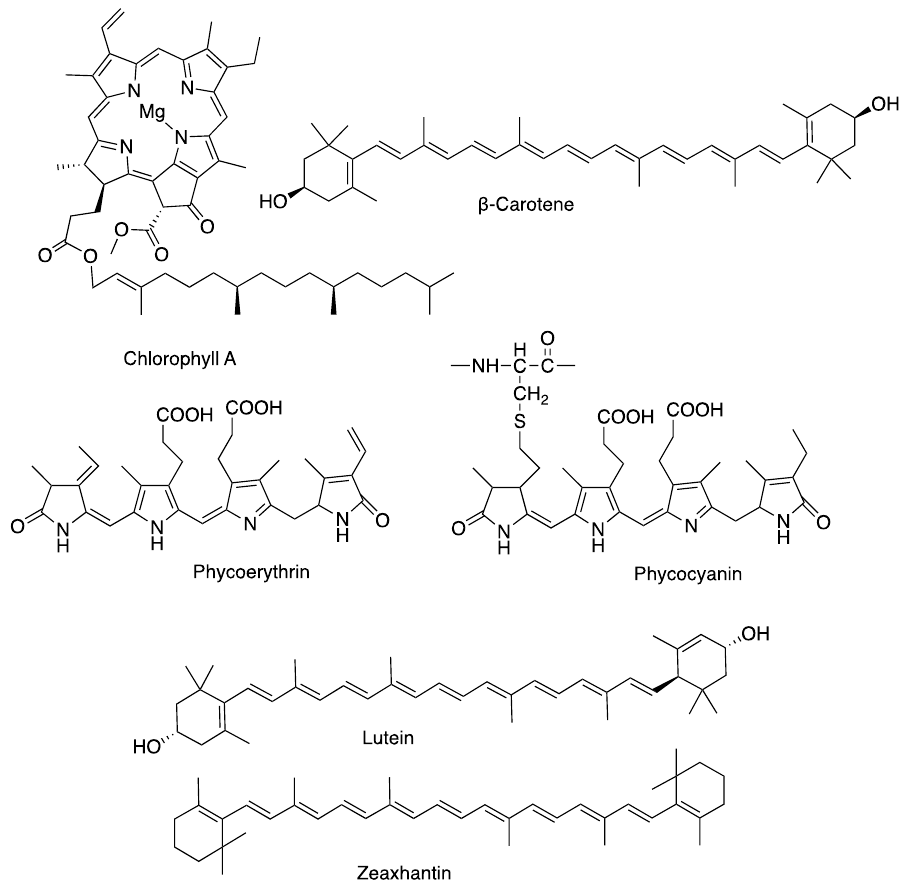
Figure 2. Pigments of Rhodophyta.